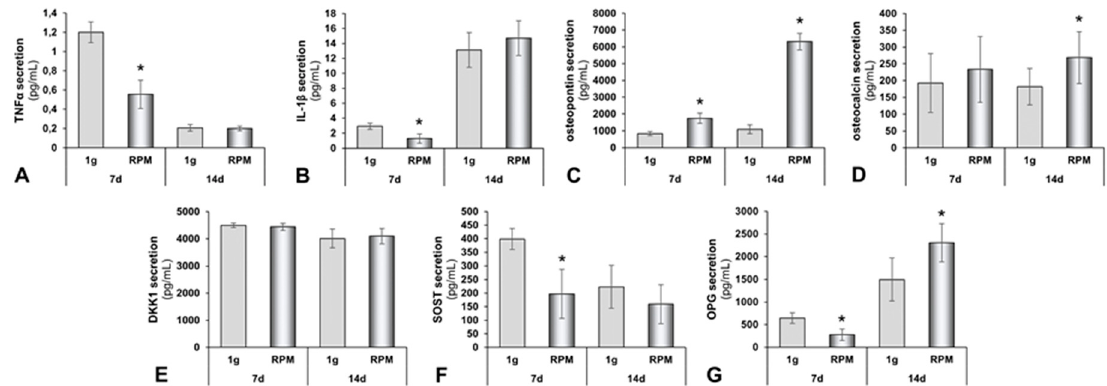
Figure 6. Protein secretion of human osteoblasts exposed to the RPM. ( A ) Tumour necrosis factor α (TNF- α ); ( B ) interleukin-1 β (IL-1 β ); ( C ) osteopontin; ( D ) osteocalcin; ( E ) dickkopf-1 (DKK1); ( F ) sclerostin (SOST); and ( G ) osteoprotegerin (OPG). All values are given as mean ± standard deviation. * p < 0.05 1 g vs. RPM, d, days.